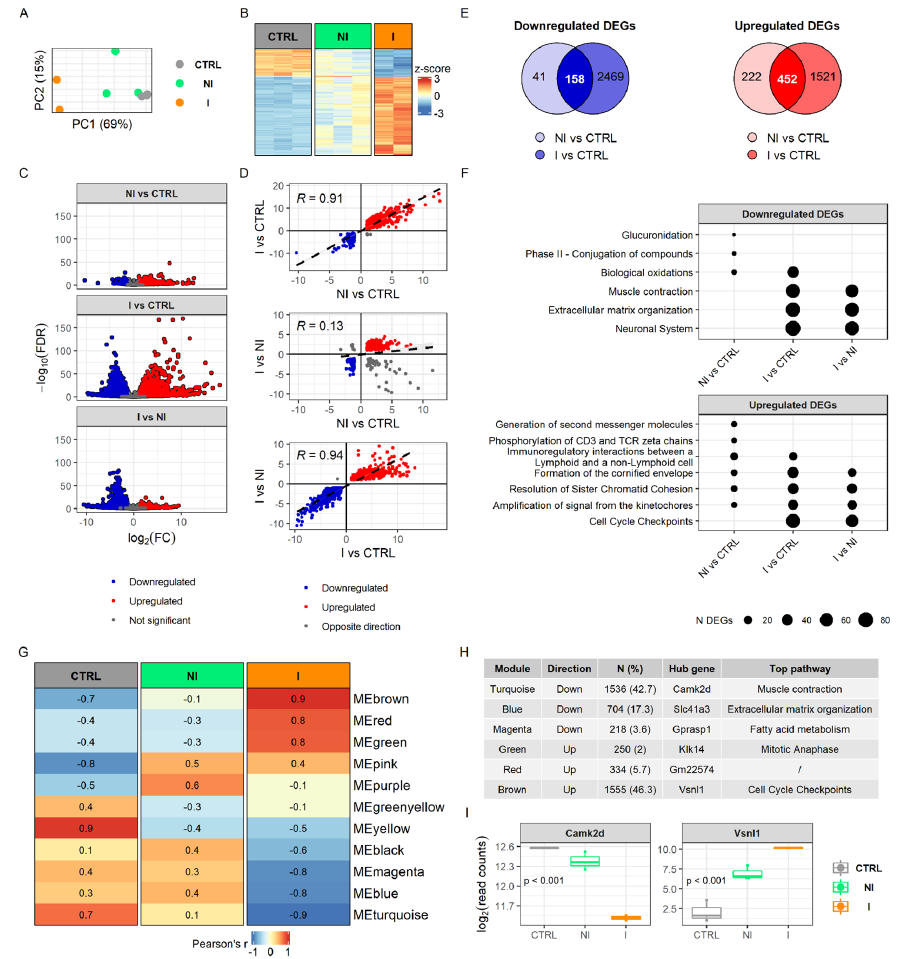
Figure 3. Gene expression profiling of mouse bladder cancers. ( A ) Principal component analysis (PCA) score plot showing sample grouping. ( B ) Heatmap of significant differentially expressed genes (DEGs) in overlap between three comparisons (NI vs. CTRL, I vs. CTRL, and I vs. NI; n DEGs = 234). ( C ) Volcano plots with log 2 fold change and FDR adjusted p -value in each comparison. ( D ) Correlation between log 2 fold change of DEGs across three comparisons with Pearson’s R correlation coefficient. ( E ) Venn diagrams of the overlap of up- and downregulated DEGs identified in non-invasive and invasive groups relative to their controls. ( F ) Top Reactome pathways enriched in down- and upregulated DEGs. ( G ) Heatmap of module eigengenes and Pearson correlation with phenotype, results from weighted gene co-expression network analysis (WGCNA), values higher than 0.75